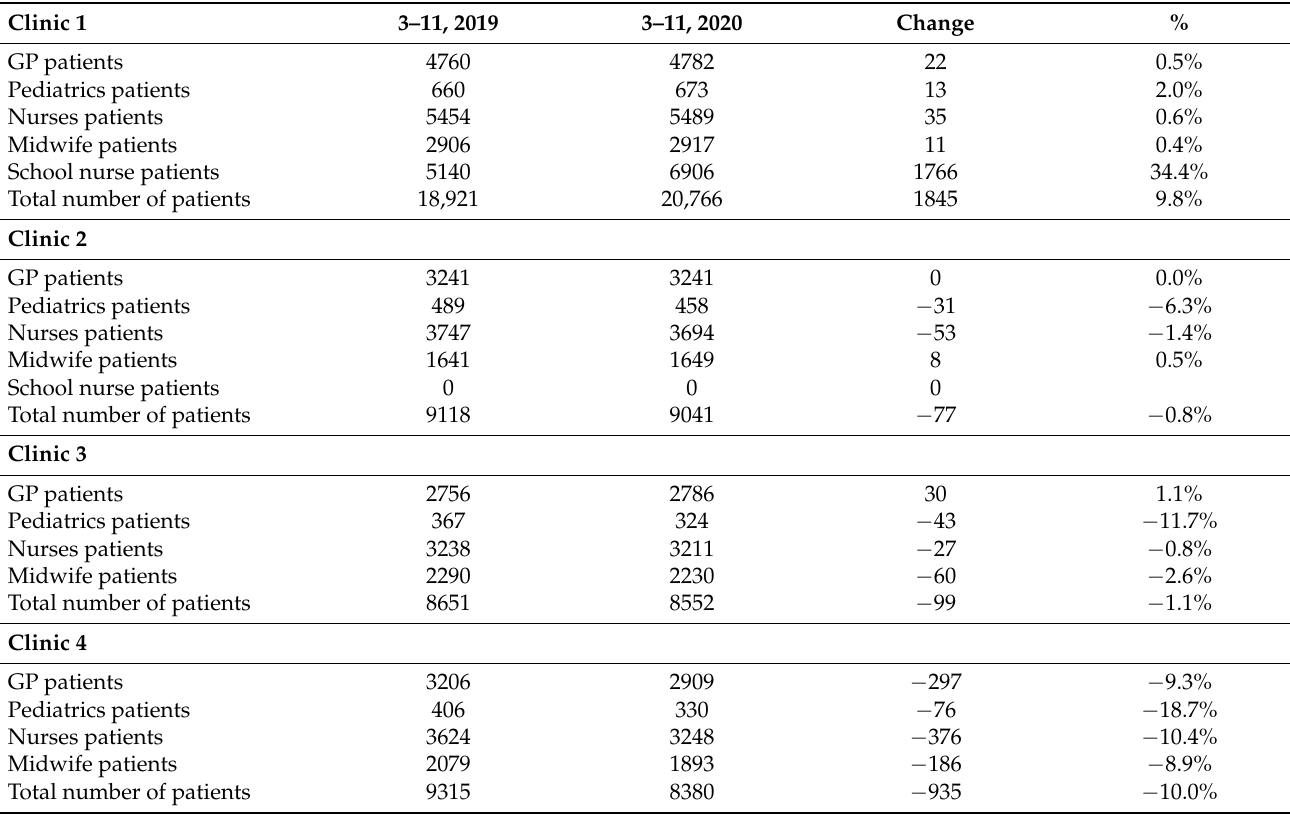
Table A2. Mean monthly numbers of patients affiliated to the clinics in studied